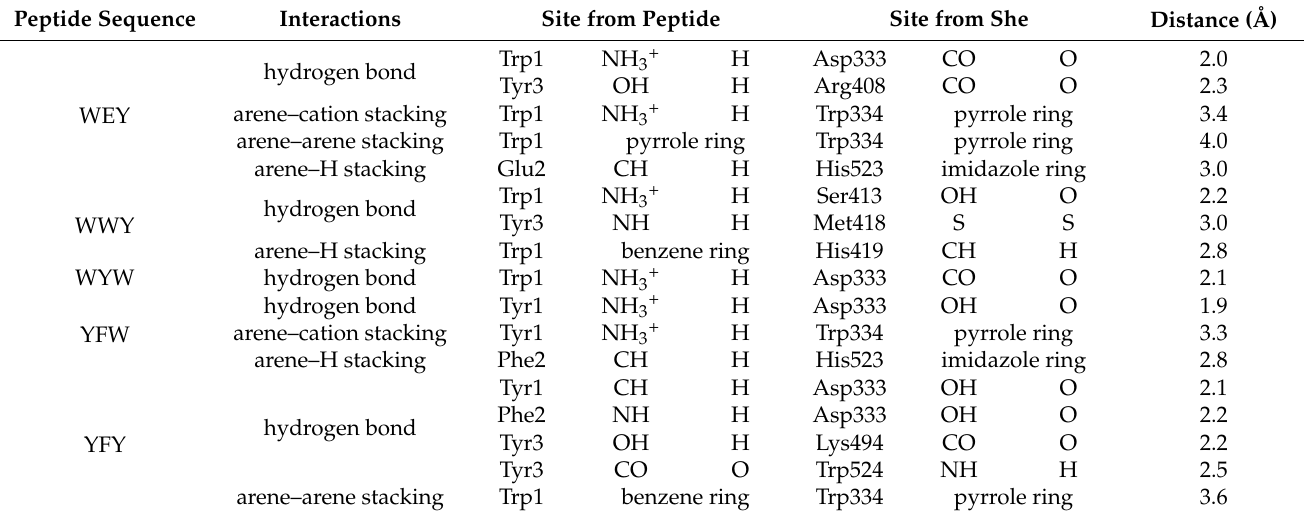
Table 2. Summary of the interactions between peptides and sEH